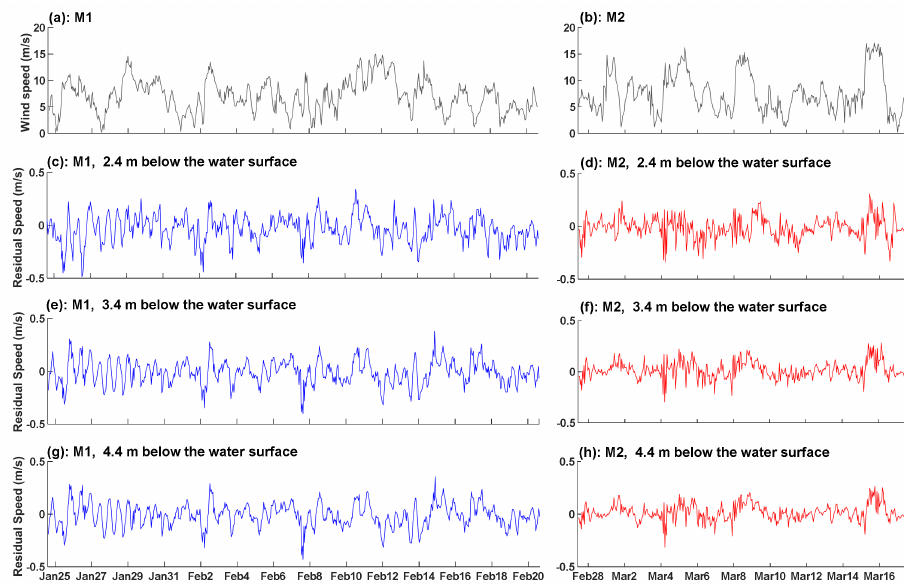
Figure 6. Variation in wind speed and upper residual current at M1 and M2 stations. ( a , b ) Wind speeds at M1 and M2 stations, respectively. ( c , d ) Residual currents at 2.4 m at M1 and M2 stations, respectively. ( e , f ) Residual currents at 3.4 m at M1 and M2 stations, respectively. ( g , h ) Residual currents at 4.4 m at M1 and M2 stations,